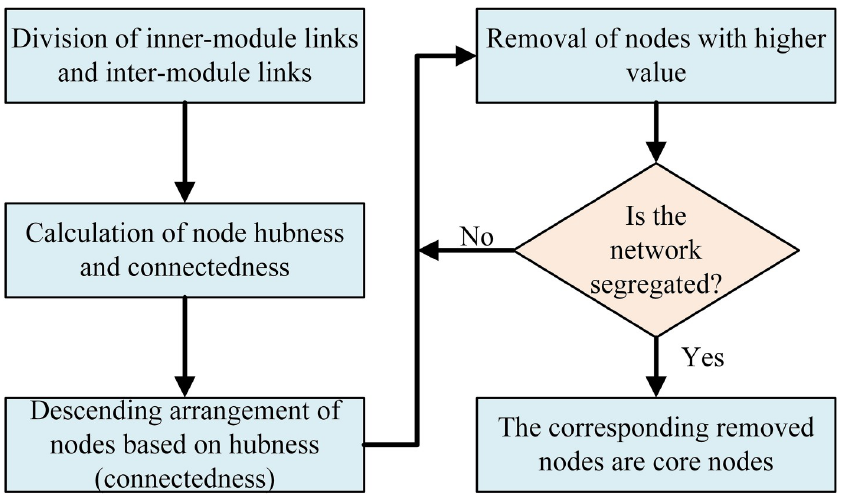
Fig 1. The flow chart of core node identification. Specifically, the links are divided into inner-module links and inter-module links. Then, for each module, the hubness (connectedness) of nodes is calculated according to the mean and standard deviation of their inner-module (inter-module) links. Nodes are sorted in descending order based on hubness and connectedness. Finally, nodes with higher values are continuously removed until the remaining network is segregated and the corresponding removed nodes are the core